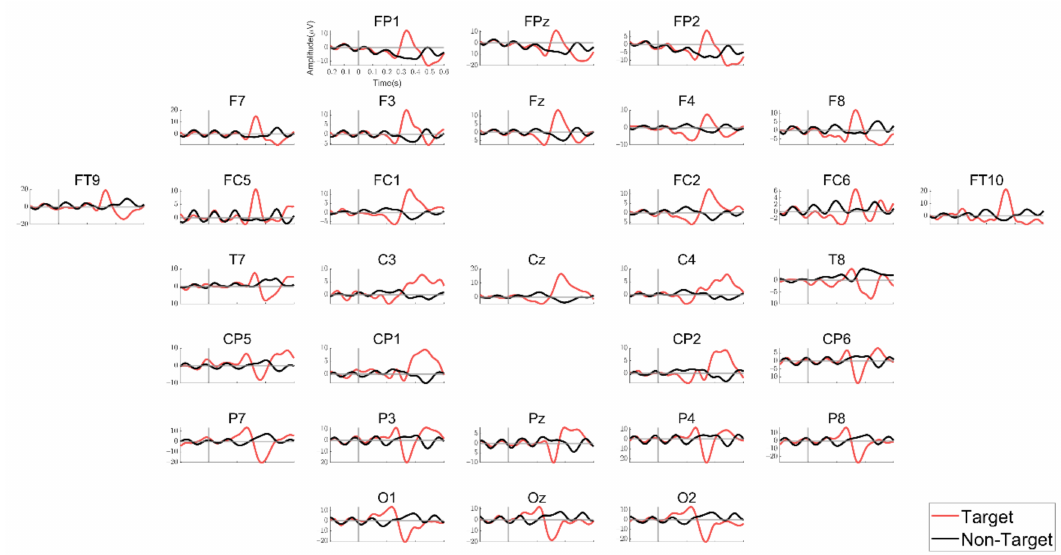
Figure 3. The grand averaged ERP across all subjects for the training session. The red line indicates ERP for the target stimulus and the black line denotes ERP for the non-target